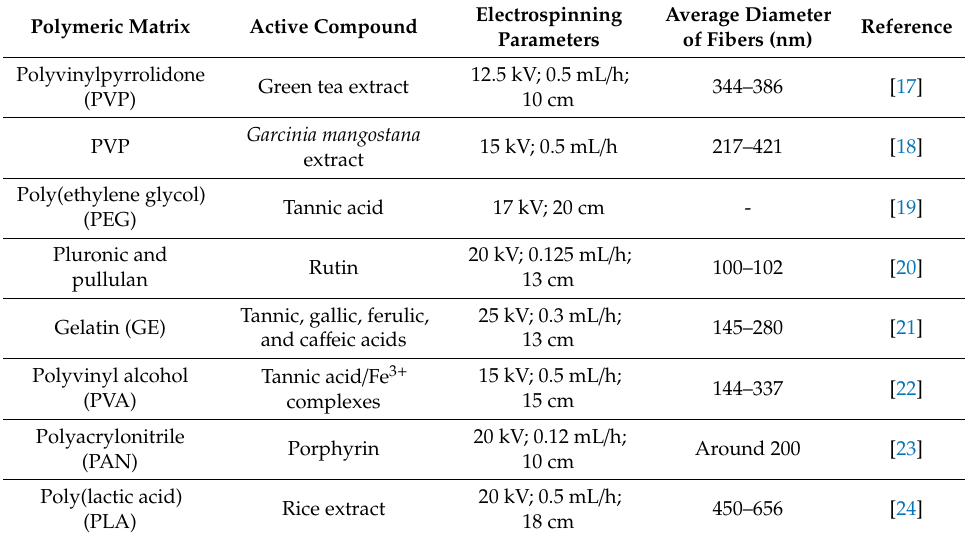
Table 1. Characteristics of nanofibers from eight reviewed articles with undefined